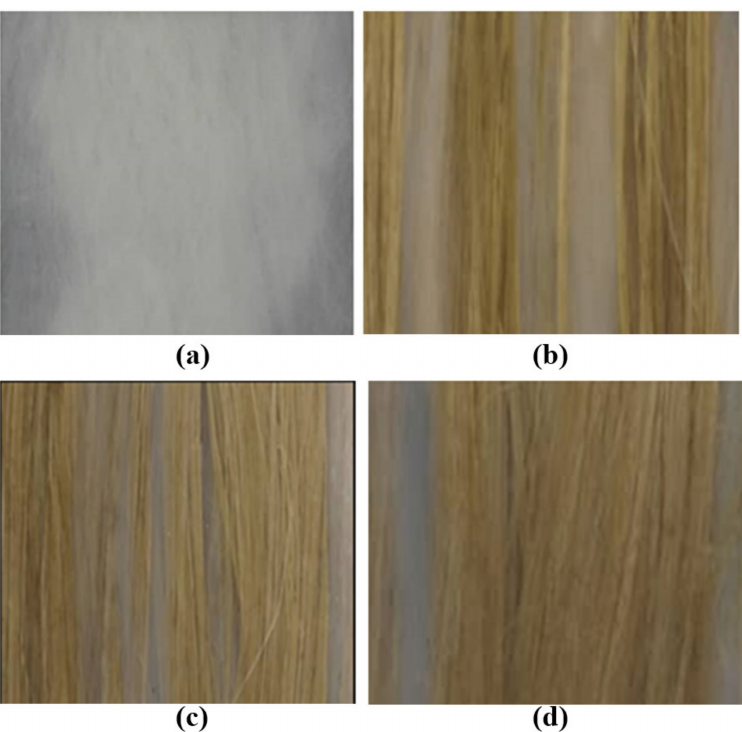
Figure 3. Observation of sample: ( a ) epoxy/Mg/PET, ( b ) epoxy/PET/KF-20, ( c ) epoxy/PET/KF-35, and ( d ) epoxy/